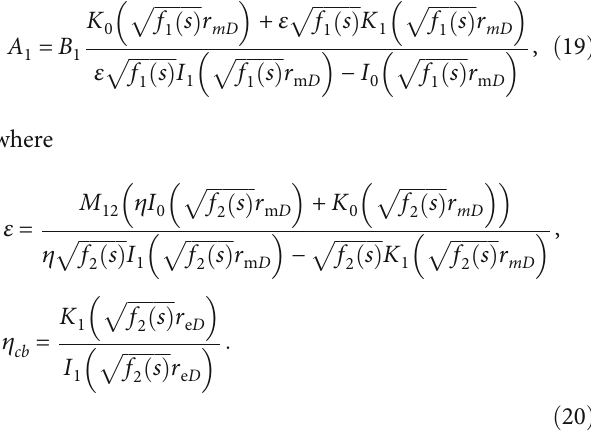
ffiffiffiffiffiffiffiffiffiffi